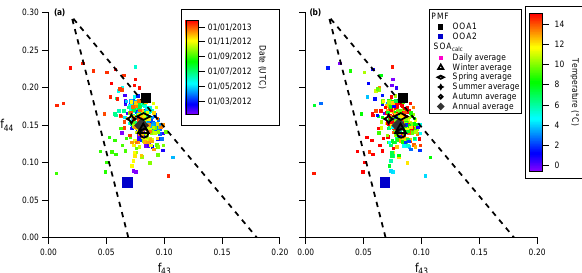
Figure 7. Daily averaged SOA within f 44 vs. f 43 space coloured by time (a) and temperature (b) , where f 44 and f 43 refer to m/z 44:SOA calc and m/z 43:SOA calc respectively. See text for more details. Daily averaged temperatures ranged from − 0.5 to 26 ◦ C, although they are only coloured here up to a maximum of 15 ◦ C for clarity. Average annual and seasonal f 44 / f 43 values for SOA are denoted in the legend. OOA1 and OOA2 PMF factors are also plotted. The outline of the triangle as defined by Ng et al. (2010) is shown by the dashed black lines. Note that the organic data do not include the summer period (see Sect.